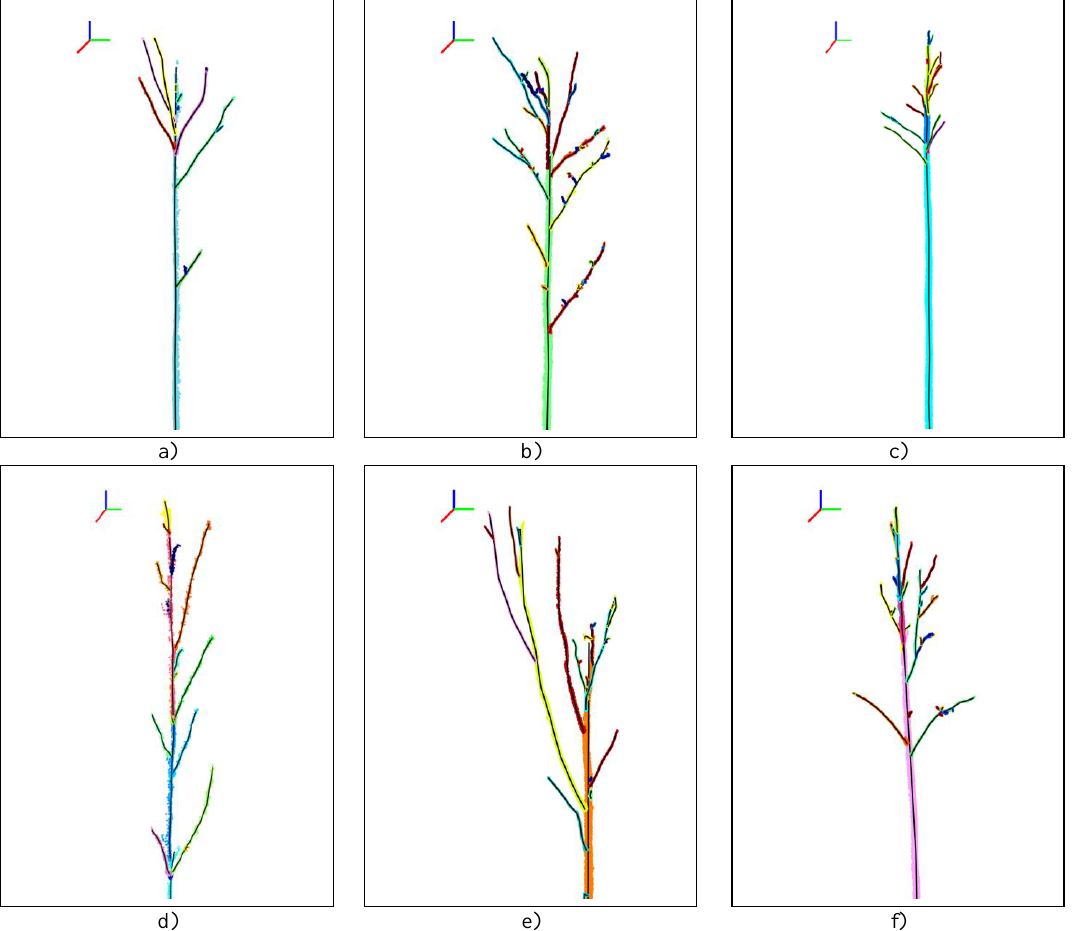
Figure 10. Each panel shows the set of 3D points that corresponds to a red connected component in the data raster shown in figure 9. The coloring of point subsets indicates the segmentation of the connected component based on the 2D skeleton as described in section 2.2. The black lines represent the skeletal structures in form of polylines, which are drawn as overlay onto the 3D point sets. Hence, each colored point subset produced the black polyline that is drawn on